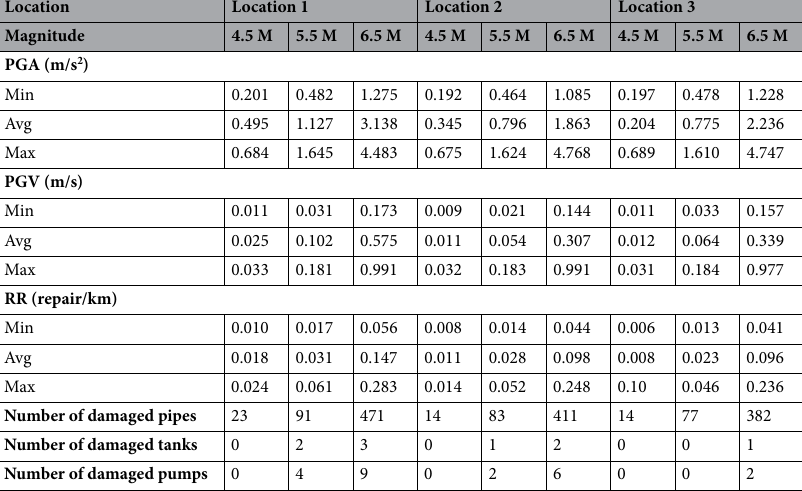
Table 4. Computation of GMPEs and the number of damaged WDN components.